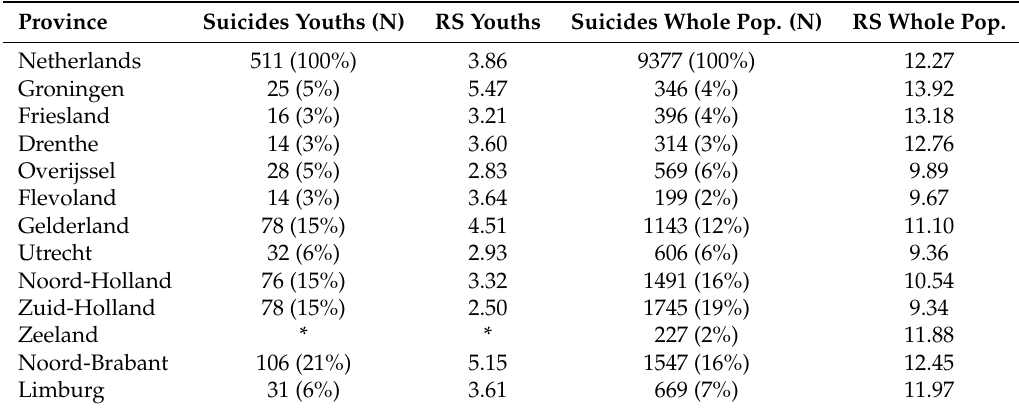
Table 4. Number of suicide victims under 23 in the period 2013–2017 by province (RS = Relative Suicide Rate per 100,000 per year) (percentage of total in Netherlands in